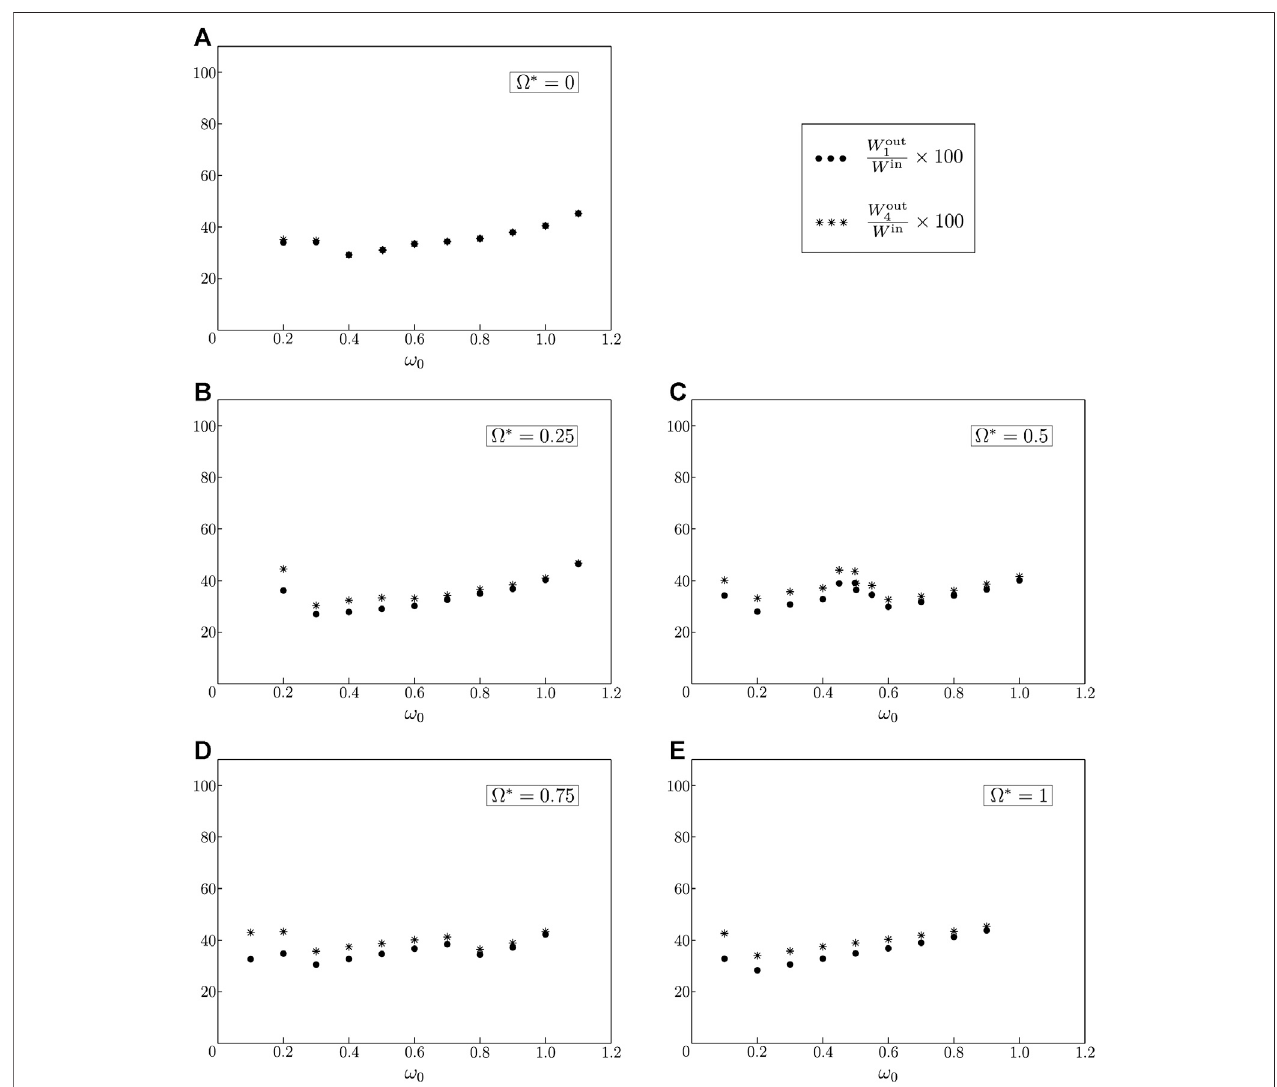
FIGURE 11 | Same as in Figure 10 , but for a vertically-acting point